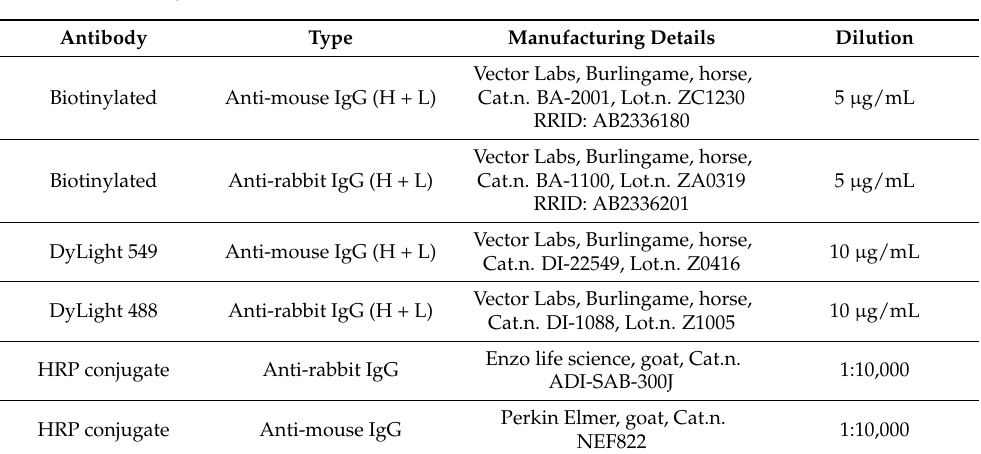
Table 2. Secondary